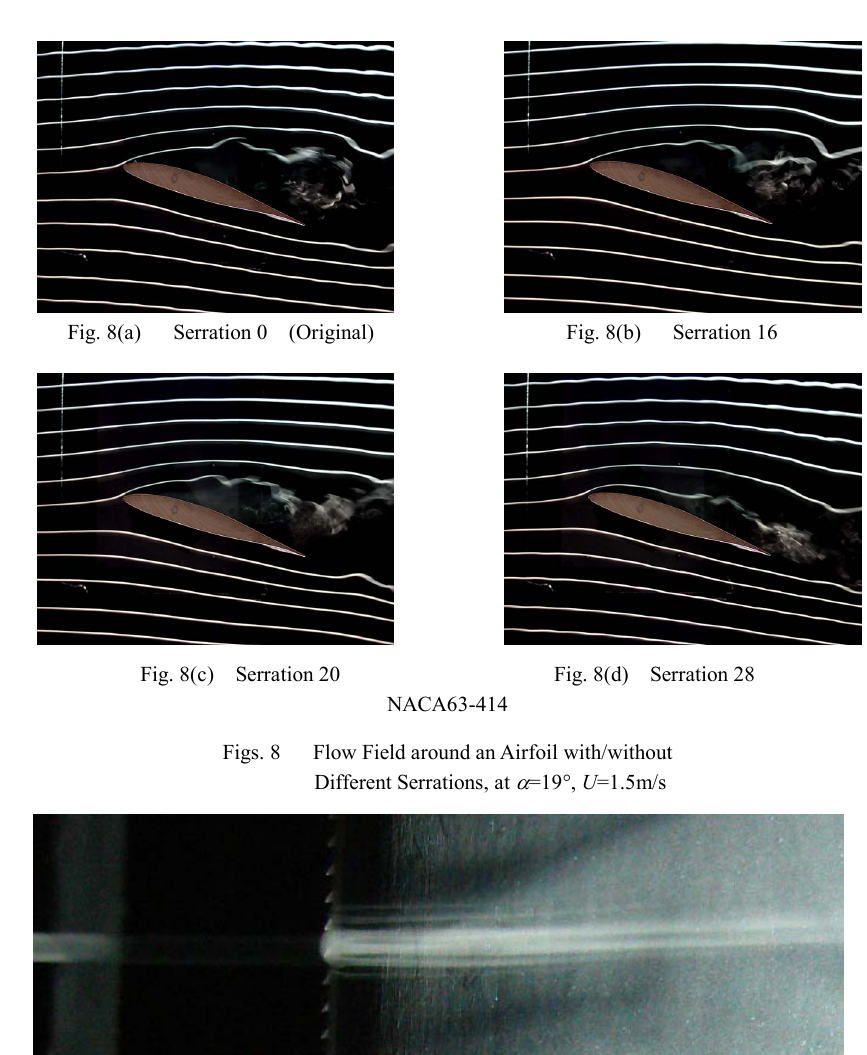
Fig. 9 The state by which a smoke line is divided into a lot of small smoke lines by the 'serration 28' of a leading